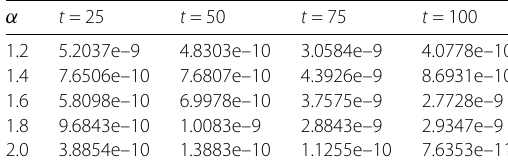
Table 3 Absolute mass errors of solutions to 3CNFSE (1) with initial conditions (22), using the ETDRK4-P22 scheme (12) ( N = 128, τ =